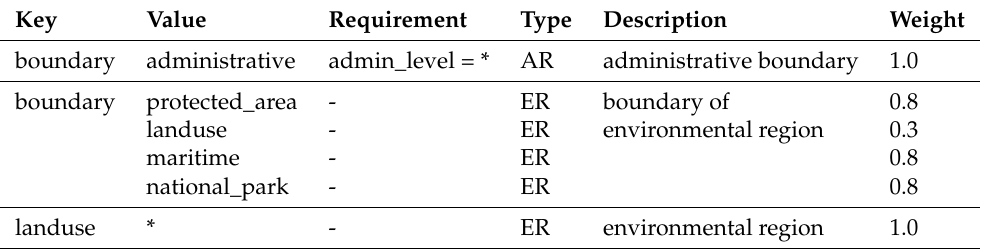
Table 4: OSM tags related to structural regions